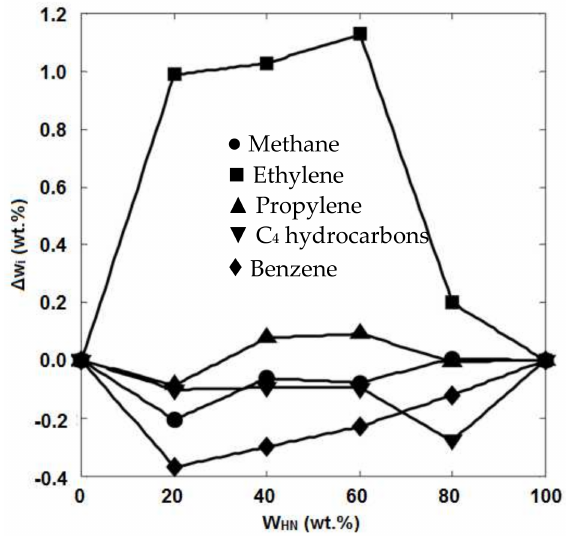
Figure 12. Potential product yield increases (T: 810 ◦ C, P: 4 bar, F: 65 Nml/min) depending on the content of heavy naphtha in the blend with light naphtha